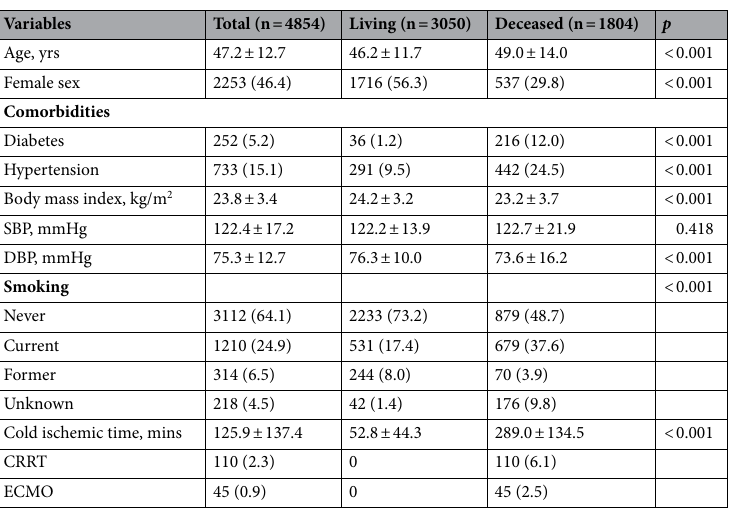
Table 2. Baseline clinical characteristics of the kidney transplant donors of Korean Organ Transplantation Registry (2014–2018). CRRT, continuous renal replacement therapy; DBP, diastolic blood pressure; ECMO, extracorporeal membrane oxygenation; SBP, systolic blood pressure.